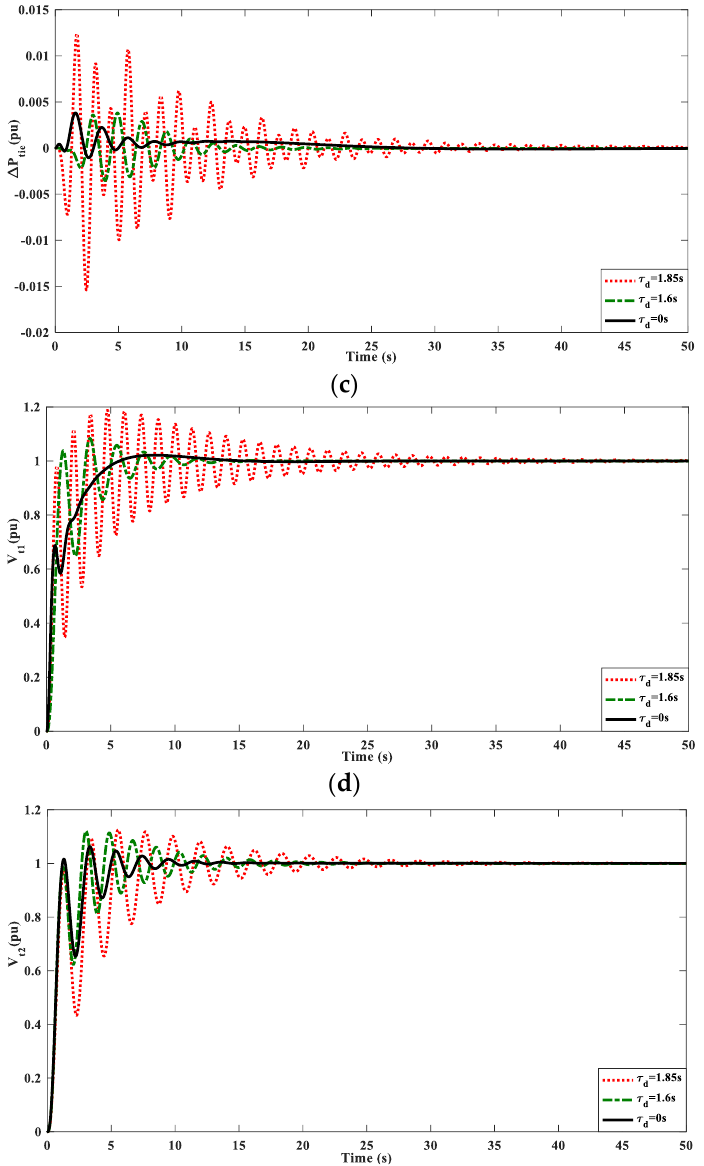
Figure 12. Dynamic responses with different time delays ( τ d ) ( a ) ∆ f 1 ; ( b ) ∆ f 2 ; ( c ) ∆ P tie ; ( d ) V t1 ; ( e ) V t2 .